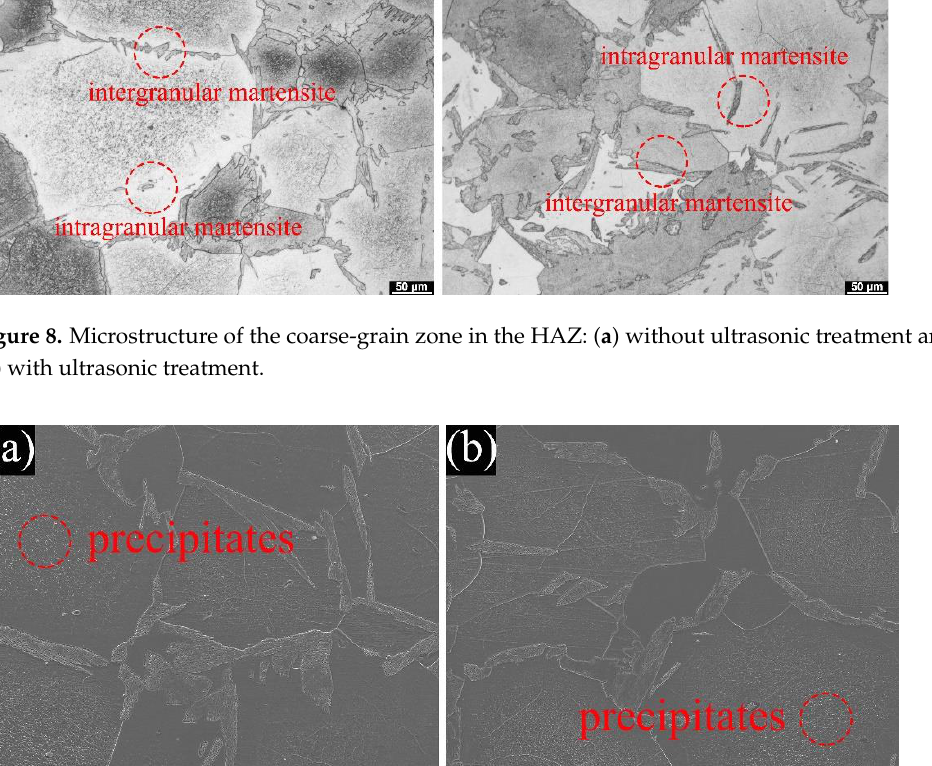
Figure 8. Microstructure of the coarse-grain zone in the HAZ: ( a ) without ultrasonic treatment and ( b ) with ultrasonic treatment. Figure 9. SEM image of the coarse-grain zone in the HAZ: ( a ) without ultrasonic treatment and ( b ) with ultrasonic treatment.